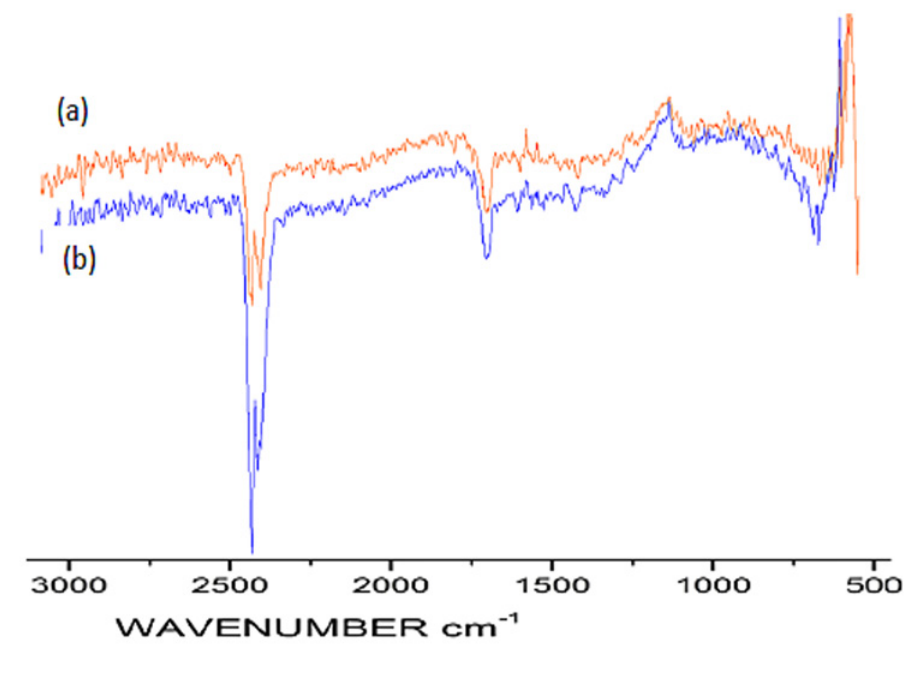
Fig 9. FTIR spectra of the (a) fresh and (b) spent Fe-ZSM-5.